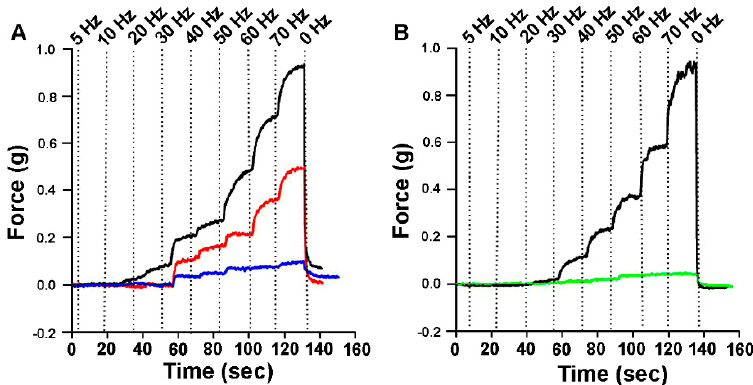
Figure 6. Forces of intact before and after ablated regions of fibers of the opener muscle over various stimulation frequencies: ( A ) The force generated by one preparation stimulated over 145 s: the top trace shows force generated by the intact opener muscle, the middle trace is the force generated with the distal fibers ablated, and the bottom trace is the force generated by the same preparation when the central fibers were ablated in addition to the distal fibers. ( B ) The force generated in a different preparation: The top trace shows force generated by the intact opener muscle, and the lower trace is the force generated with central fibers ablated. The vertical dotted lines indicate the start of the stimulation frequency listed at the top.